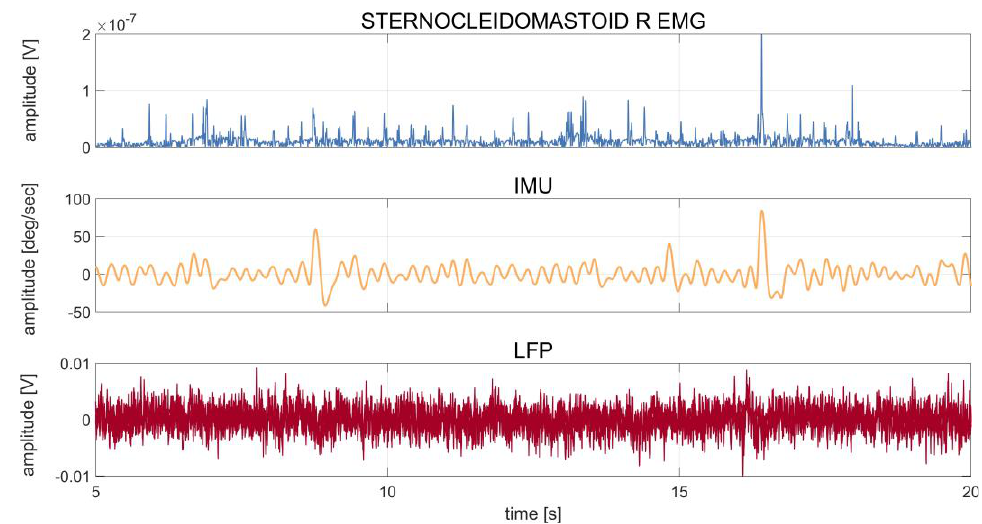
Figure 1. Patient DW08: time series of 20 s of recording of the right sternocleidomastoid muscle (first row), IMU (second row), and LFP (third row) during rest. The IMU time series were averaged over the three axes (x, y, z), and the LFP time series were averaged over the six contact pairs (0 – 3, 0 – 2, 1 – 3, left and right). The patient showed a dystonic tremor during the acquisition, as also confirmed by clinical notes and a video evaluation of the recording. The waveform of the tremor peaks captured by the IMU can also be observed in the LFPs.